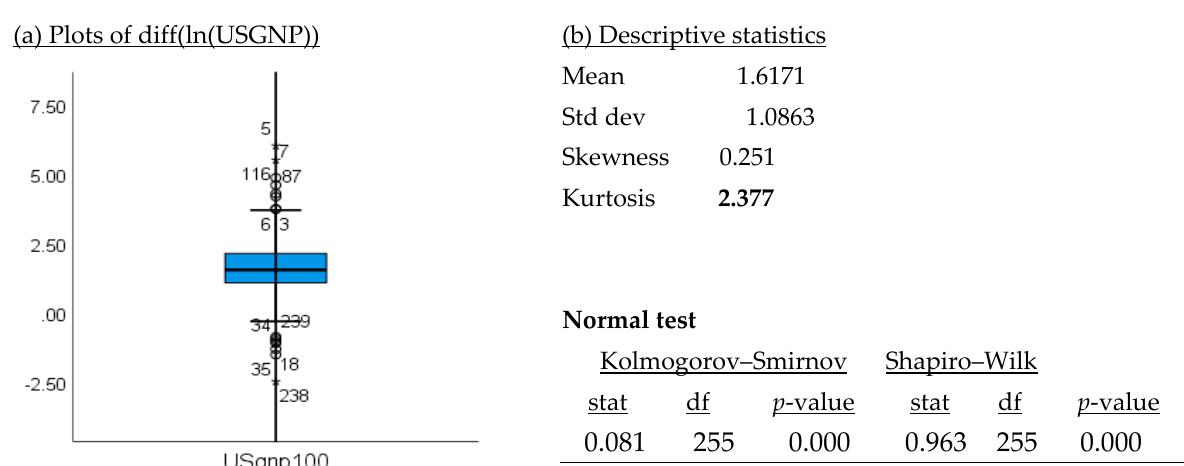
Figure 13. Estimations for USGNP data using FCL, EML, and FCN.